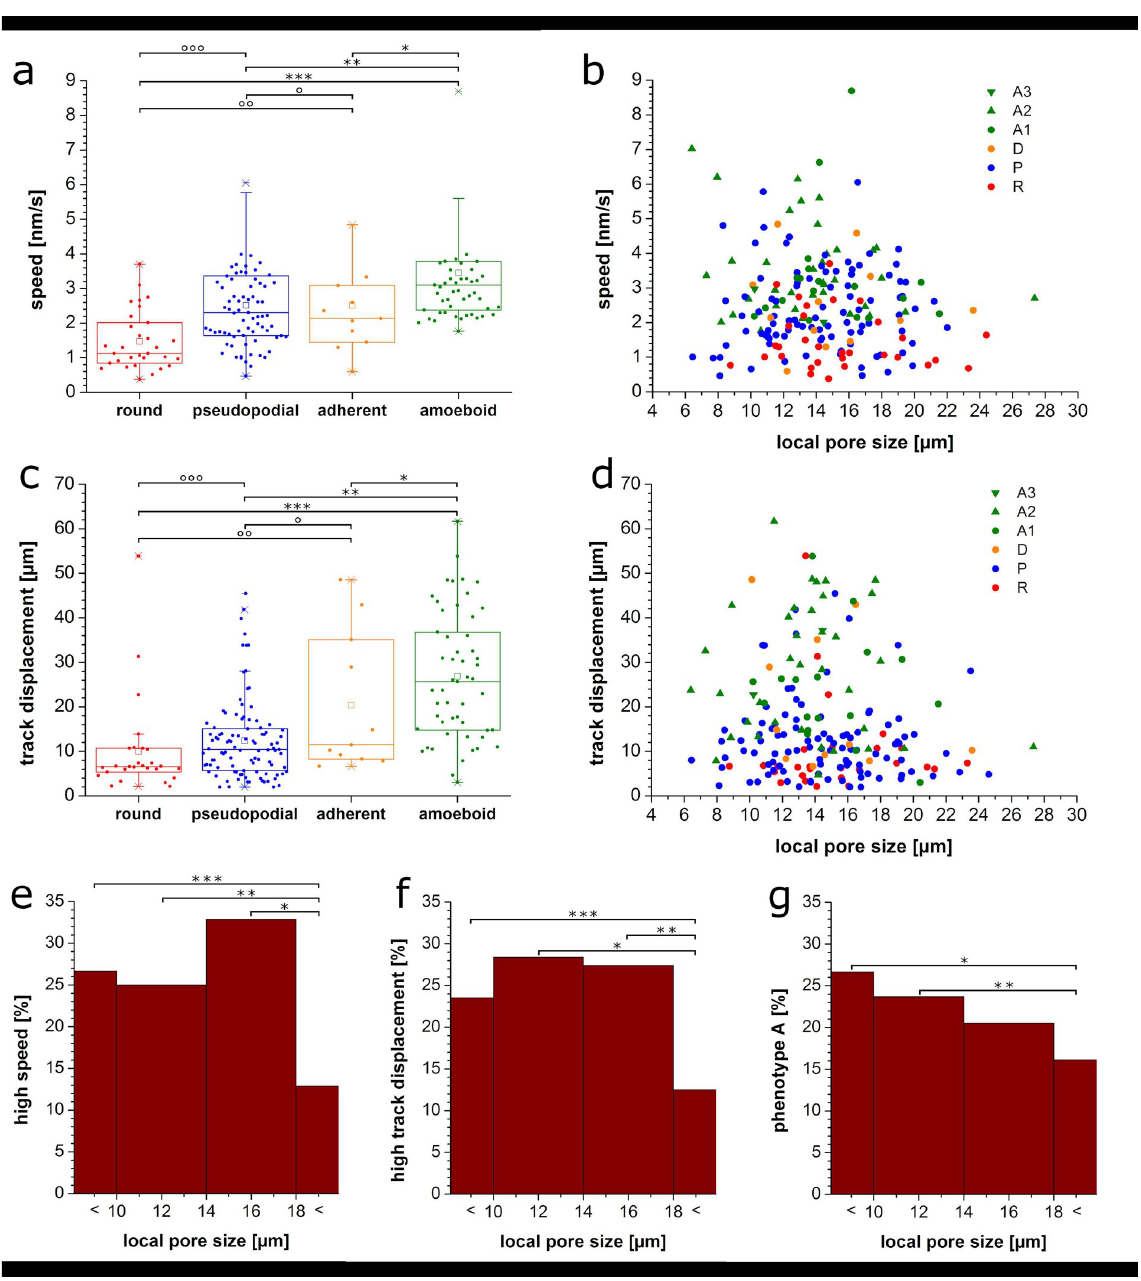
Fig 4. Migration parameters depending on phenotype and pore size. a) speeds for different phenotypes, p < 0.001 ( � p < 0.02, �� p < 0.001, ��� p < 0.001,˚p < 0.95,˚˚p < 0.02,˚˚˚p < 0.001); b) speed versus local pore size for different phenotypes; c) track displacement for different phenotypes, p < 0.001,( � p < 0.1, �� p < 0.001, ��� p < 0.001,˚p < 0.2,˚˚p < 0.005,˚˚˚p < 0.02); d) track displacement versus local pore size for different phenotypes including round (R), pseudopodial (P), adherent (D), and amoeboid with the subforms ellipsoid with leading edge (A1), squeezing (A2), and rear driven (A3) cells; e) fraction of cells in respective pore size with speed values greater than 3.2 nm/s (0.75 percentile of all cells), 4 μ m binning, ( � p < 0.01, �� p < 0.1, ��� p < 0.06); f) fraction of cells in respective pore size with track displacement values greater than 22.8 nm/s (0.75 percentile of all cells), 4 μ m binning, ( � p < 0.05, �� p < 0.05, ��� p < 0.1); g) fraction of cells in respective pore size with amoeboid phenotype, 4 μ m binning, ( � p < 0.1, �� p < 0.1).